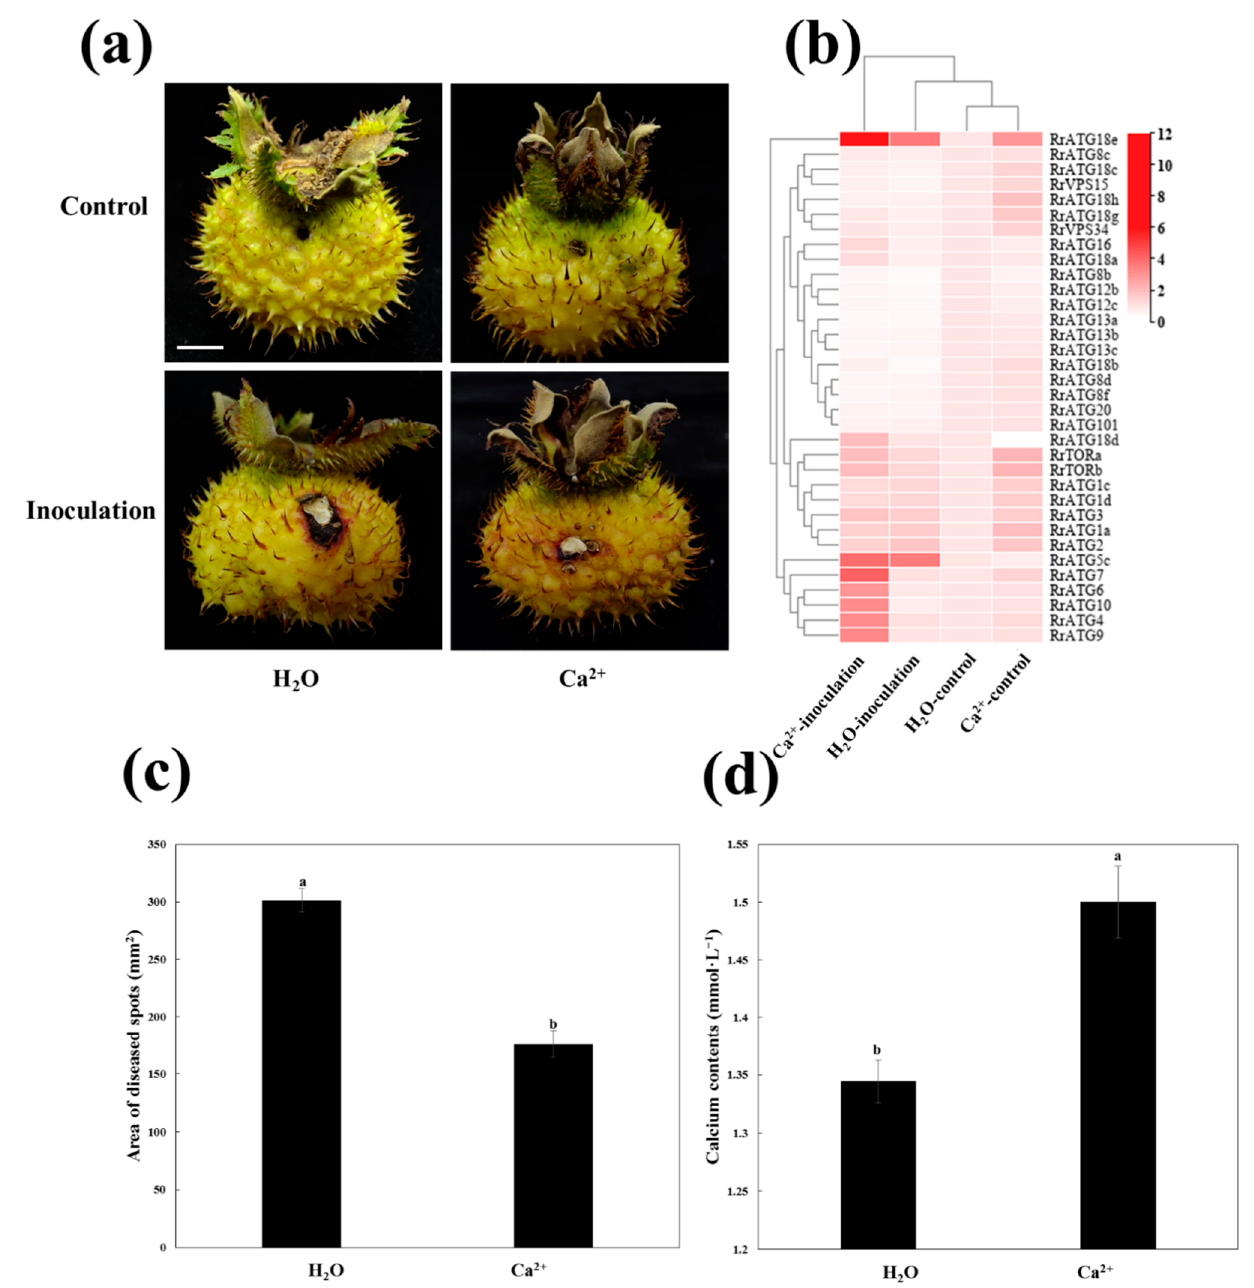
Figure 6. Schematic diagram of Ca 2+ enhanced the resistance of R. roxburghii fruits to TRD. ( a ) Phe- notypes of fruits inoculated with C. fructicola and control PDA after H 2 O and Ca 2+ treatments at 13 DPI. Bar = 1 cm. ( b ) The heat map showed the expression of RrATGs under di ff erent treatments at 13 DPI. The H 2 O-control represented the expression of inoculated control PDA after H 2 O-treated, the H 2 O-inoculation represented the expression of inoculated C. fructicola PDA after H 2 O-treated, the Ca 2+ -control represented the expression of inoculated control PDA after Ca 2+ -treated, the Ca 2+ - inoculation represented the expression of inoculated C. fructicola PDA after Ca 2+ -treated. The expres- sion of H 2 O-control was considered “1”, red and white represented the higher and lower expression levels, respectively. ( c ) The area of diseased spots of fruits inoculated with C. fructicola PDA after H 2 O and Ca 2+ treatments at 13 DPI. ( d ) Total calcium content of fruits after H 2 O and Ca 2+ treatments at 13 DPI. Data are means of standard errors of three replicates. The le tt ers on the column denote signi fi cant di ff erences ( p < 0.05, ANOVA) between H 2 O and Ca 2+ treatments.